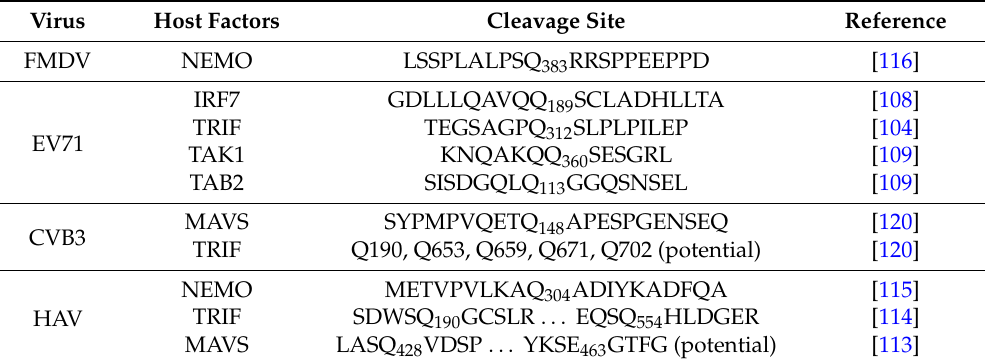
Table 4. Cleavage of innate immune-related proteins by 3C pro